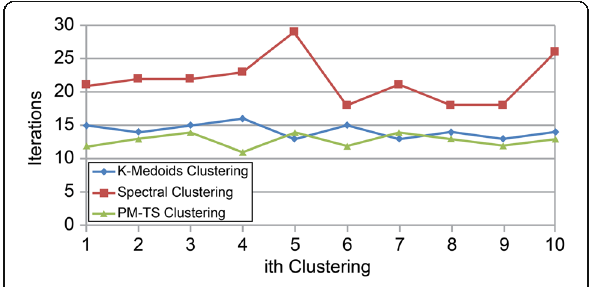
Fig. 8 Iterations of the three algorithms, run ten